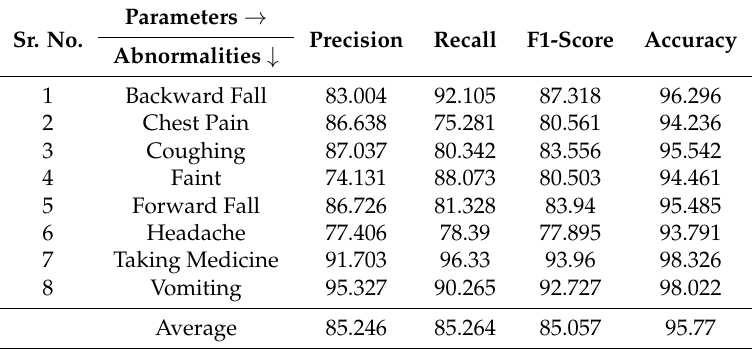
Table 4. Performance evaluation of dataset with the ratio of